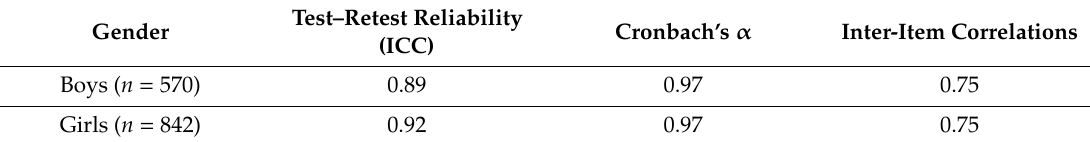
Table 4. Reliability and validity of the Lithuanian Body Appreciation Scale-2 (the adolescent sample, n = 1412).